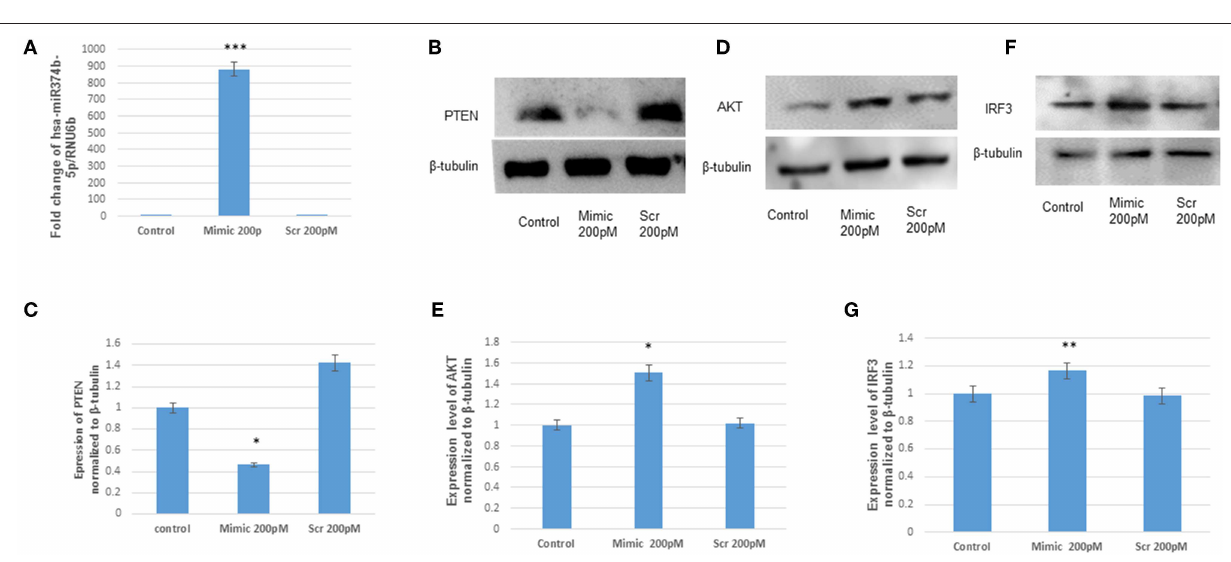
FIGURE 3 | The hsa-miR-374b-5p targets PTEN and activates the expression of AKT and IRF3. (A) qRT-PCR of hsa-miR-374b-5p overexpressed in human microglial cells by using RNA oligos at 200 pmol conc. (B) The immunoblots showing the suppression of PTEN by 70%, 48h post transfection. (C) The densitometry of PTEN. (D) The immunoblots showing up-regulation of AKT by 1.5-fold. (E) Densitometry of AKT. (F) The immunoblots showing up-regulation of IRF3 by 1.2-fold upon overexpression. (G) Densitometry of IRF3. The data are shown as mean ± S.E from three independent experiments ( n = 3 ). The fold change is significant where * denotes P < 0.05, ** denotes P < 0.01, *** denotes P <